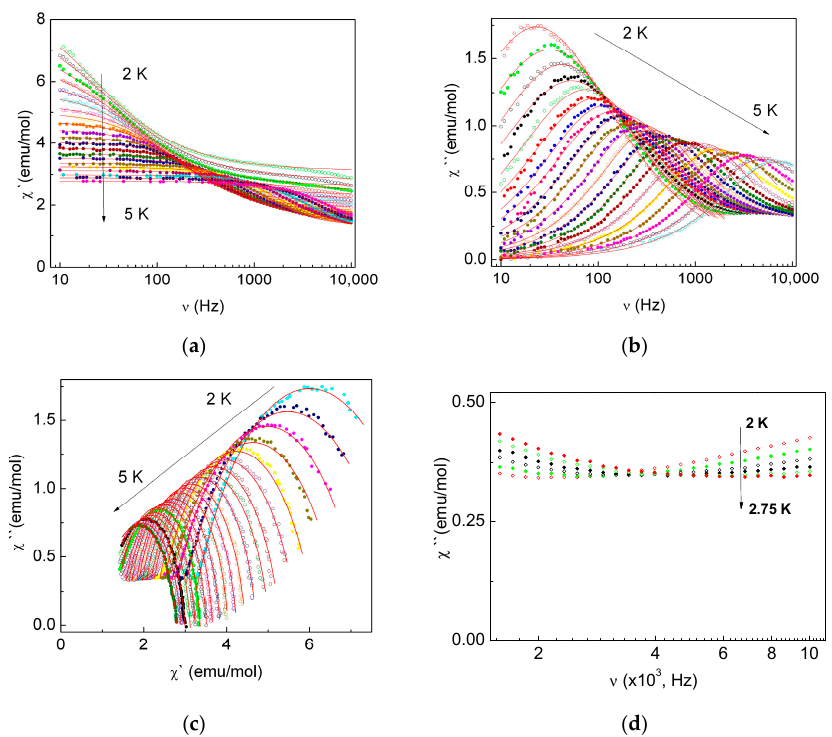
Figure 11. The frequency dependence of the χ ′ ( ν ) ( a ) and χ ′′ ( ν ) ( b ) under the magnetic field of H = 300 Oe, its fitting by the modified Debye model and the Cole–Cole diagram ( c ) at different temperatures and high frequency secondary relaxation process ( d ) for 2-Dy ; circles are the experimental data and red lines are the fitting curves.